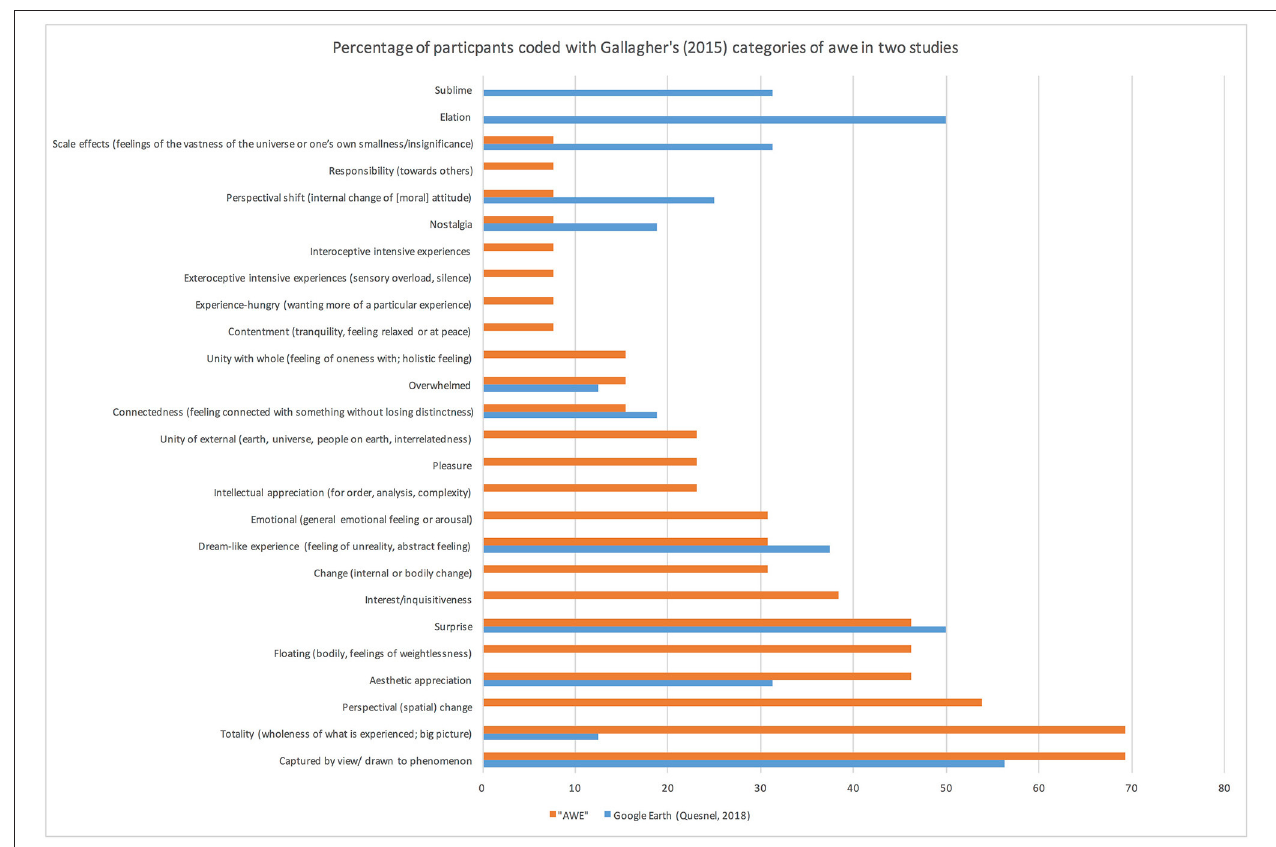
FIGURE 8 | The percentage of participants, that had statements coded with hermeneutics analyses of categories of awe (Gallagher et al., 2015) in current study and Quesnel and Riecke